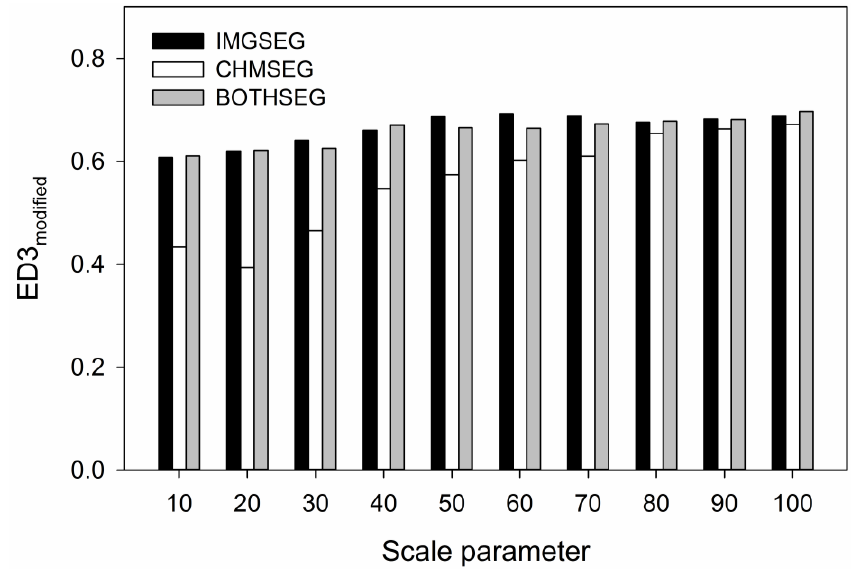
Figure 4. ED3 Modified values for the canopy gap delineation results using multispectral image (IMGCHM), LiDAR derived CHM (CHMSEG), and both image and CHM (BOTHSEG) as a function of the scale parameter ranging between 10 and 100 by an interval of